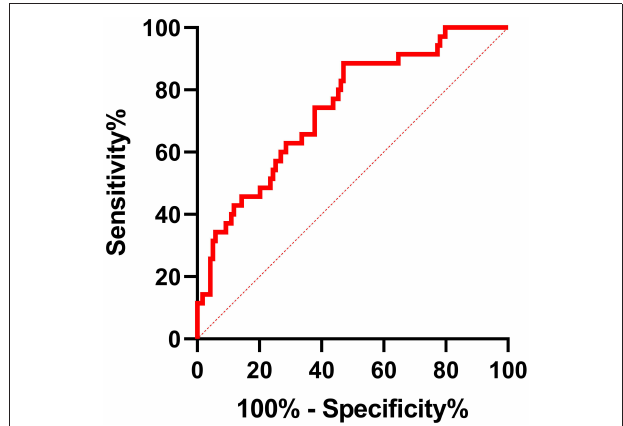
FIGURE 2 | ROC curve analysis for LTL in distinguishing PsAF patients from patients with PAF. AUC of shorter LTL was 0.63 (95% CI: 0.56–0.70, p < 0.001), with sensitivity and specificity of 56.03% and 82.04%, respectively. The optimum cut-off value for LTL was 1.175.